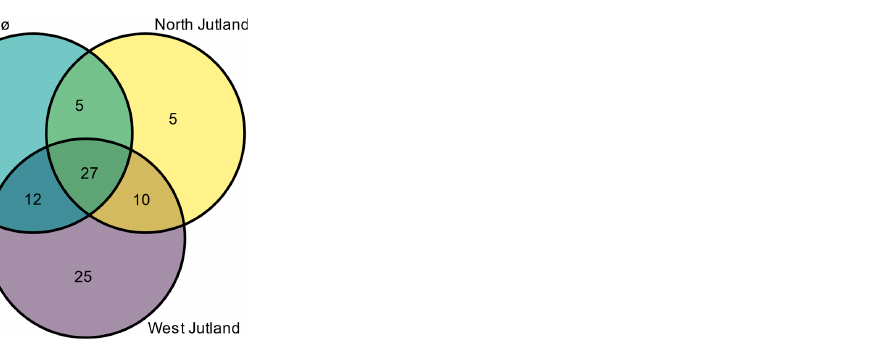
Figure 6. Venn diagram of the distribution of alleles between regions for all loci in the contemporary dataset.